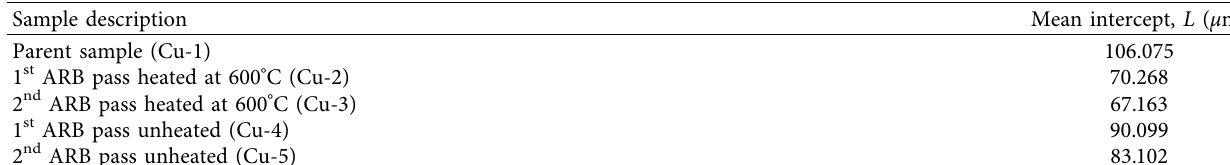
Table 7: Grain size measurements.